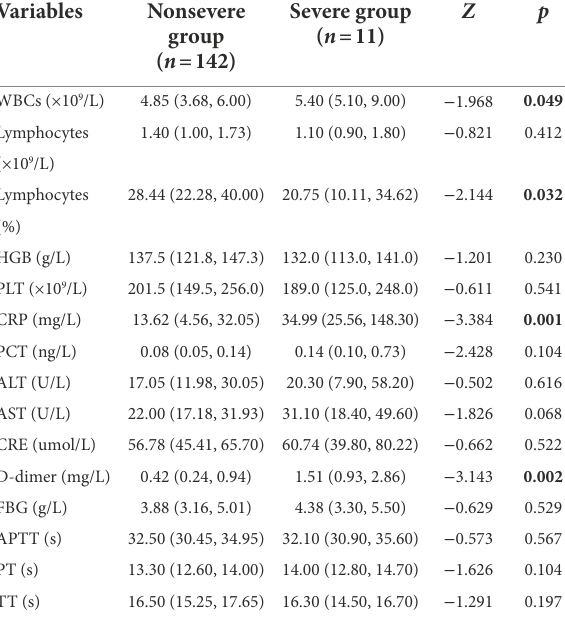
TABLE 3 Univariate analysis of risk factors associated with severe COVID-19. Nonsevere Severe group group [ n (%)] [ n